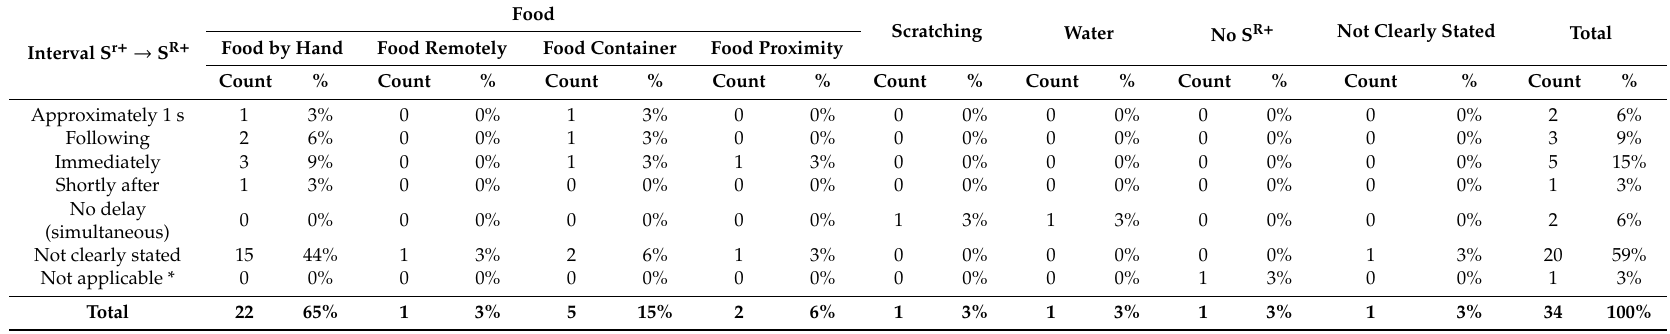
Table 7. Information extracted from the reviewed studies on the interval between the conditioned reinforcer (S r + ) and the delivery of the unconditioned reinforcement (S R + ) reported across all eligible